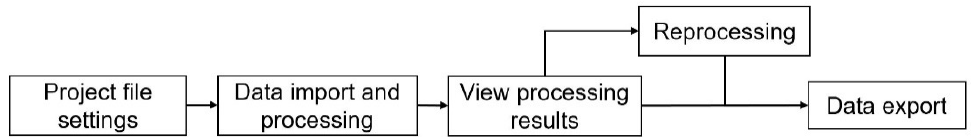
Figure 7. GeoSLAM Hub data processing flow chart.